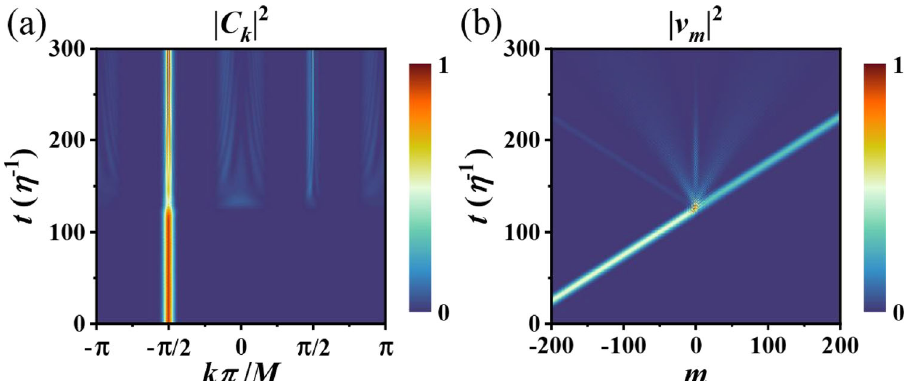
Fig. 3 The generation of photonic bound states in the k -space. a Normalized wave function of the photon in the k -space. b The normalized probability distribution of photon in different resonators versus the time. In both fi gures, simulations are performed in the k -space with Ω = 2.05 η